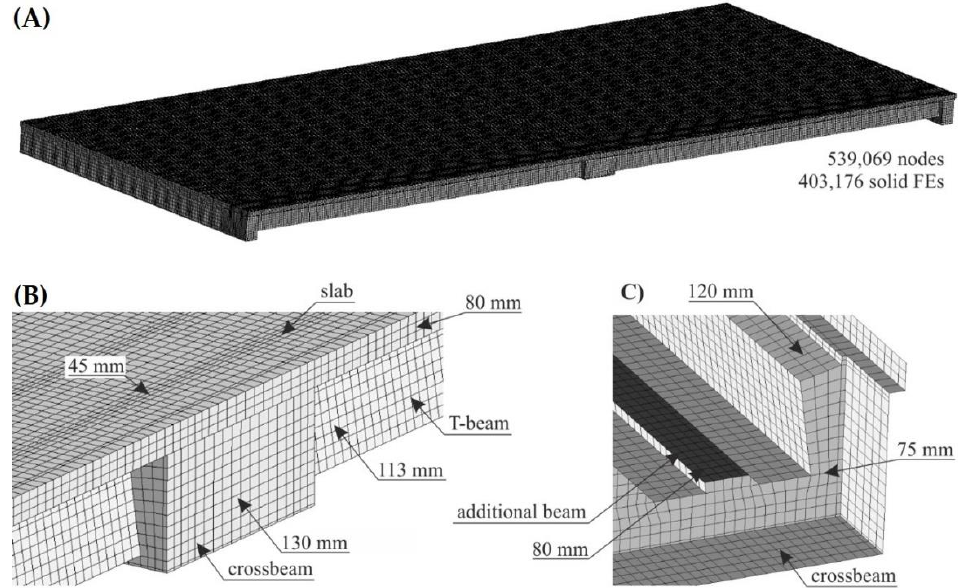
Figure 7. Details of the discretisation of the bridge structure numerical model: ( A ) general view of FEM mesh, ( B ) detail of the model in the vicinity of the intermediate crossbeam, and ( C ) detail of the model in the vicinity of the end crossbeam.